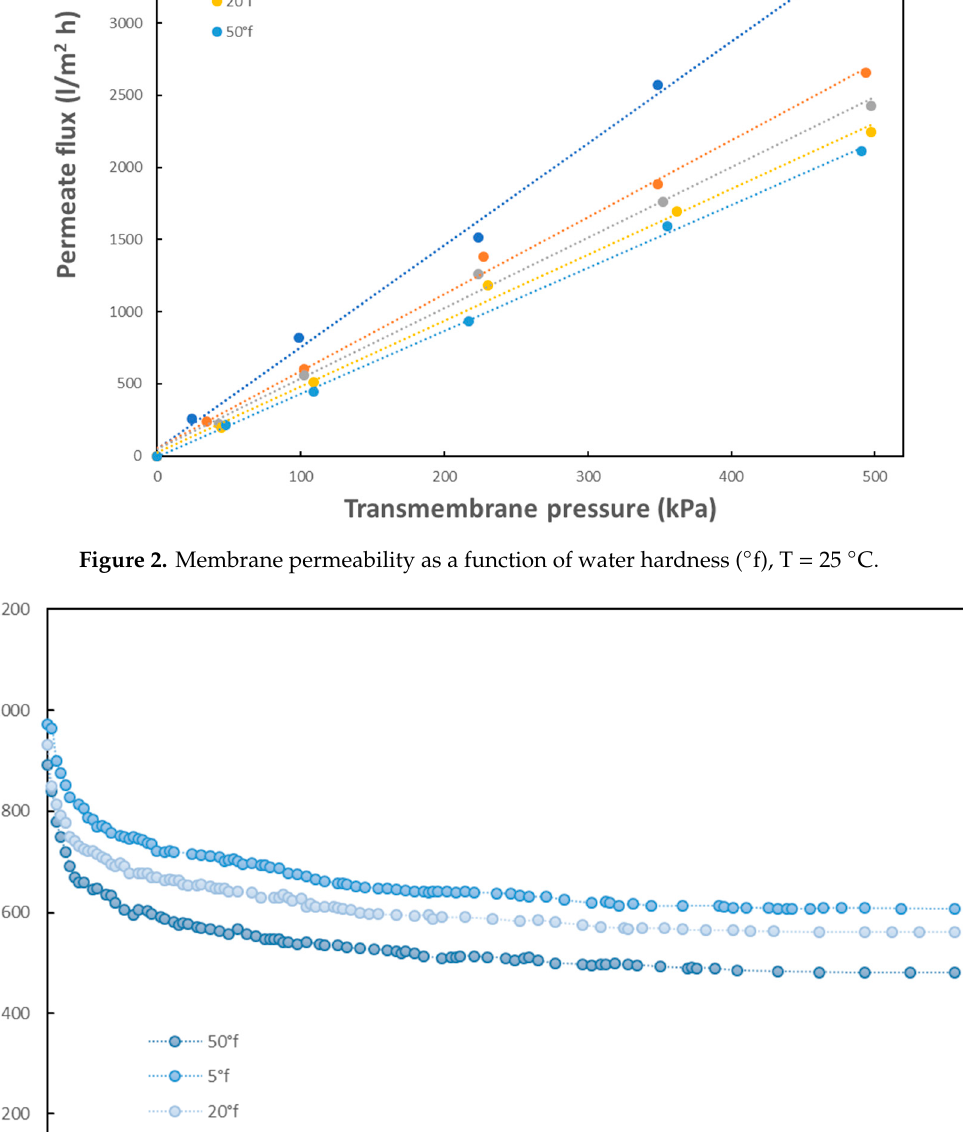
Figure 3. Long term experiments for water of different hardness; T = 25 °C, TMP = 100 kPa.